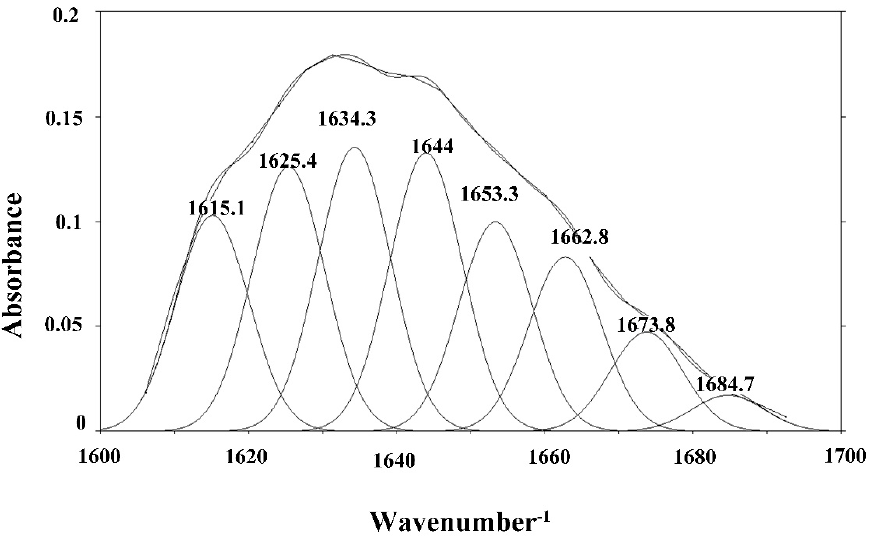
Figure 5. Fitting FTIR chart for the OVA standard.